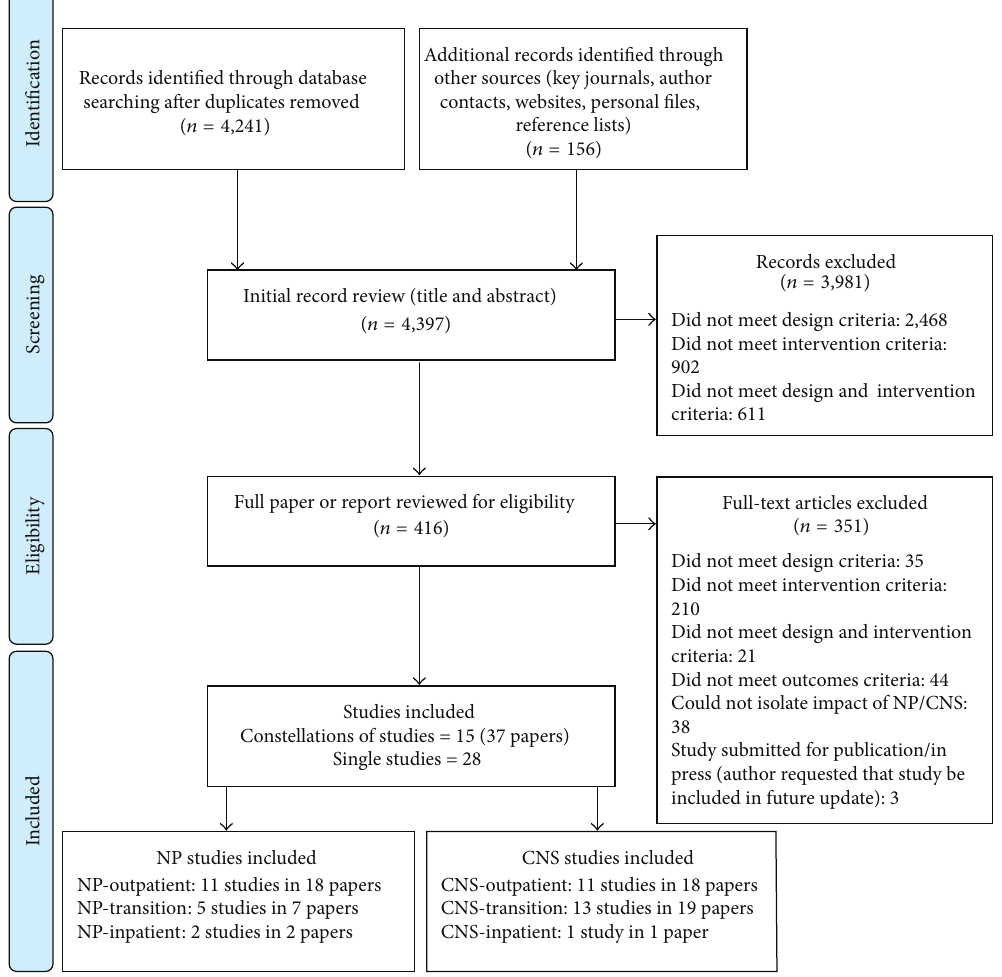
Figure 1: Identification and screening of relevant studies. Flow diagram adapted from Moher et al.